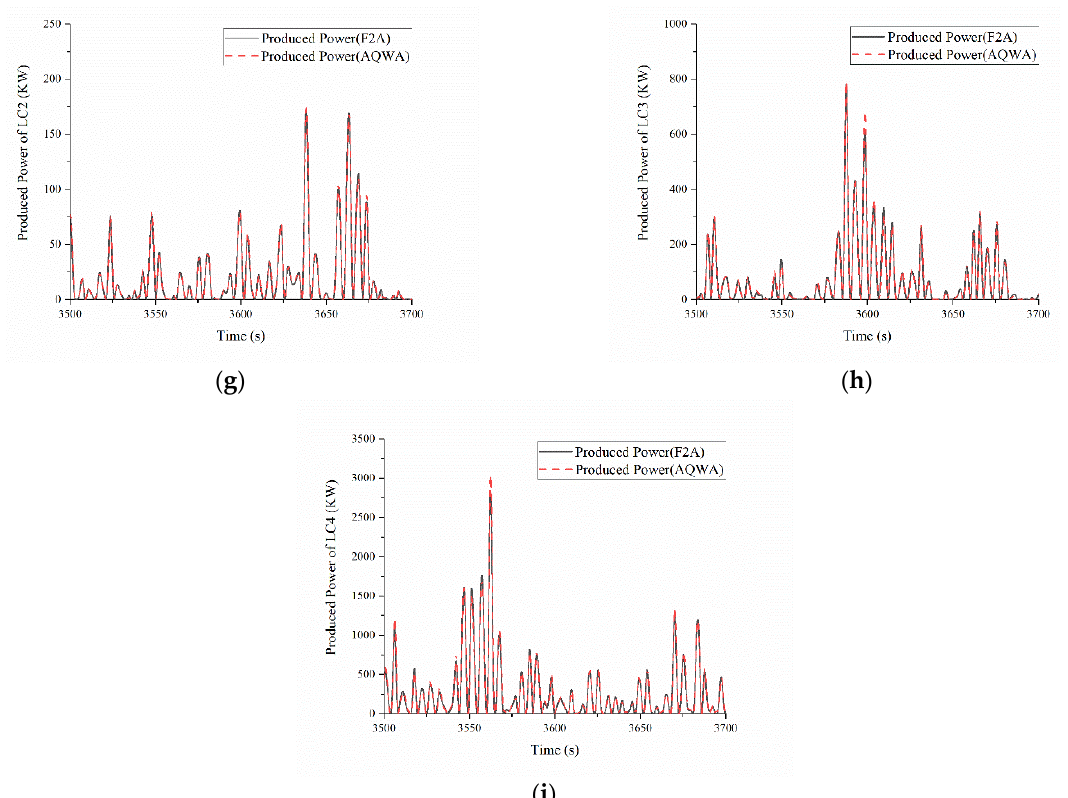
Figure 11. Time series of different responses of the combined structure: ( a ) Relative Heave Velocity of LC2, ( b ) Damping Force of LC2, ( c ) Relative Heave Velocity of LC3, ( d ) Damping Force of LC3, ( e ) Relative Heave Velocity of LC4, ( f ) Damping Force of LC4, ( g ) Produced Power of LC2, ( h ) Produced Power of LC3, ( i ) Produced Power of LC4.